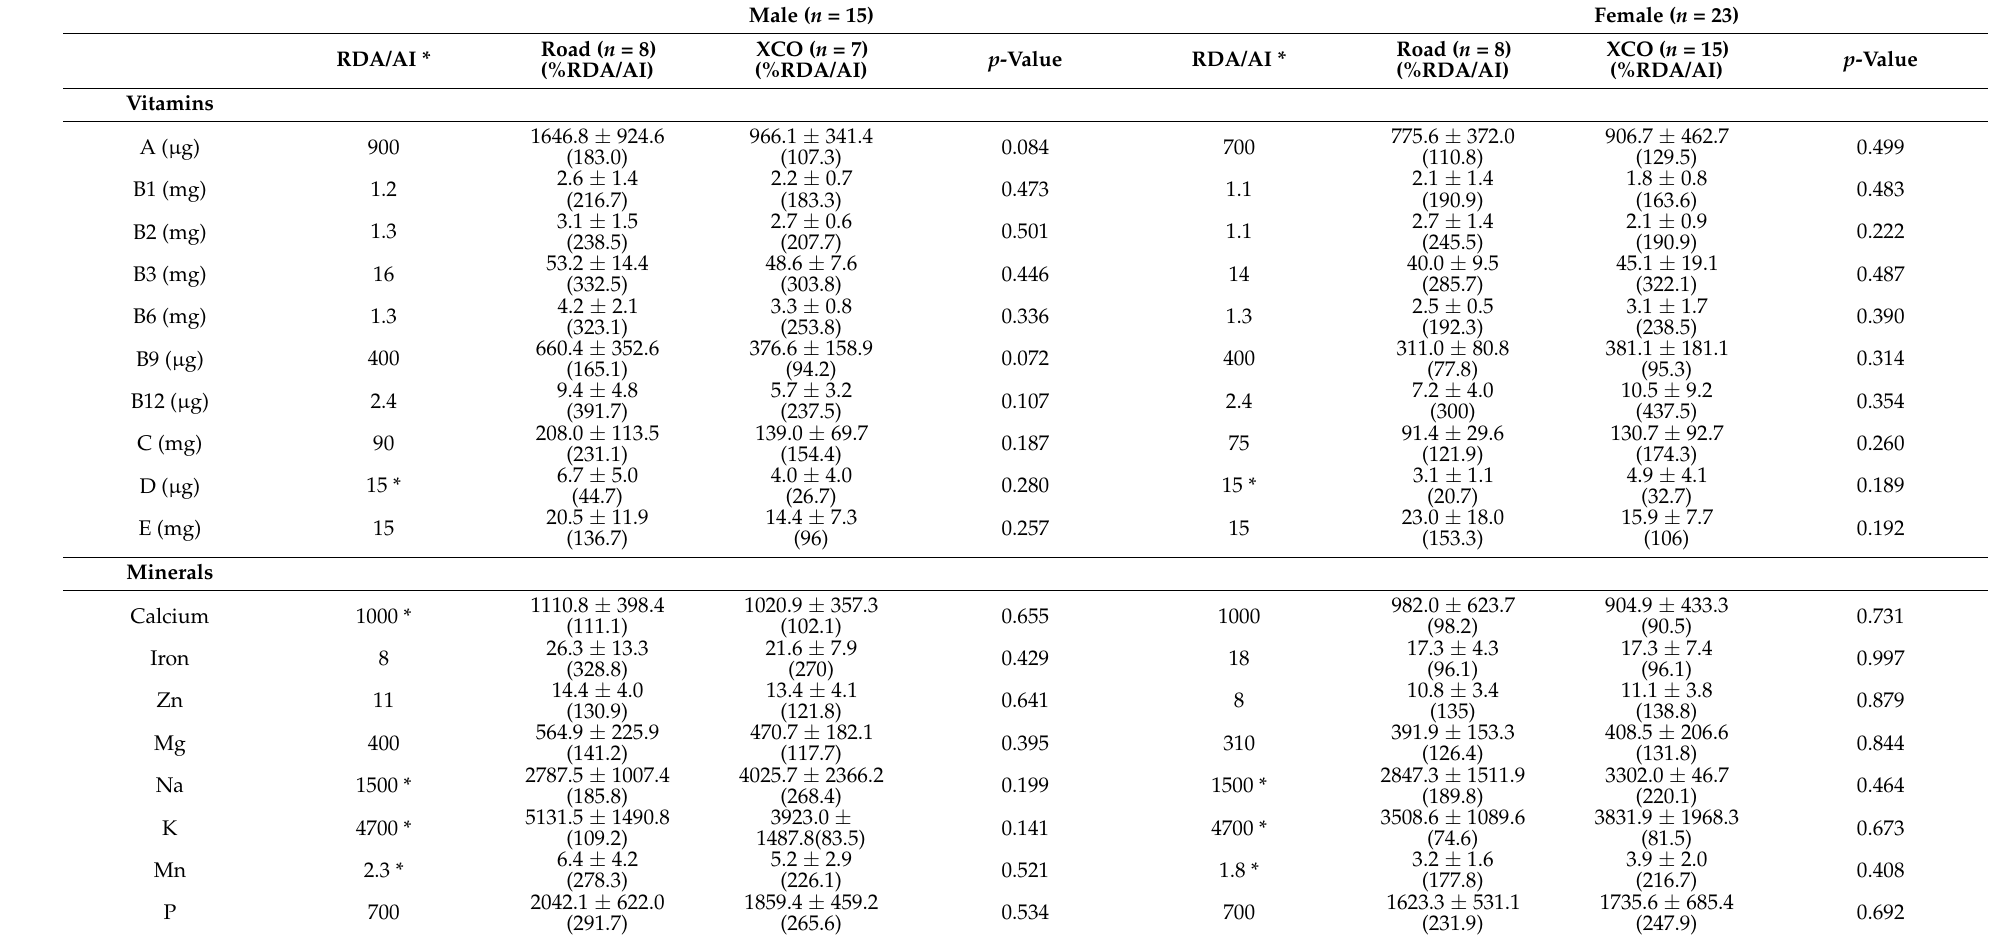
Table 3. Average daily vitamins and mineral intake of cyclists during